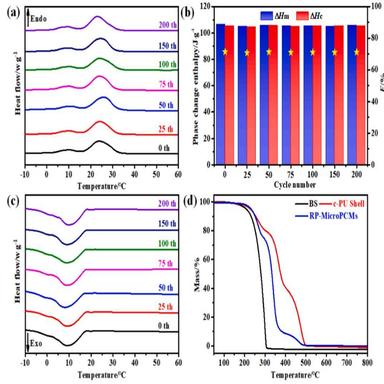
(a) DSC heating curves, (b) phase change enthalpies and E%, (c) DSC cooling curves and (d) TG curves of RP-MciroPCMs after various thermal cyclic times.